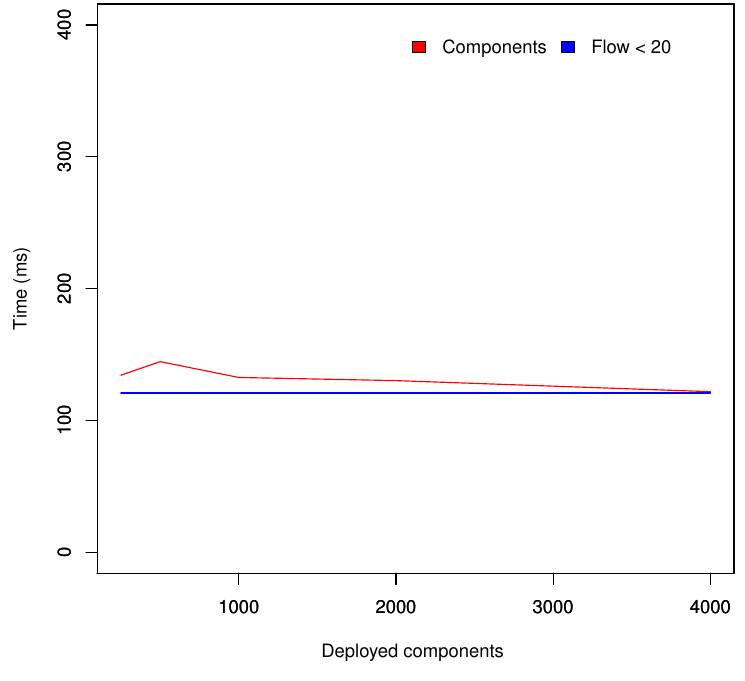
Figure 10. Location discovery response time with respect to the PoCo components